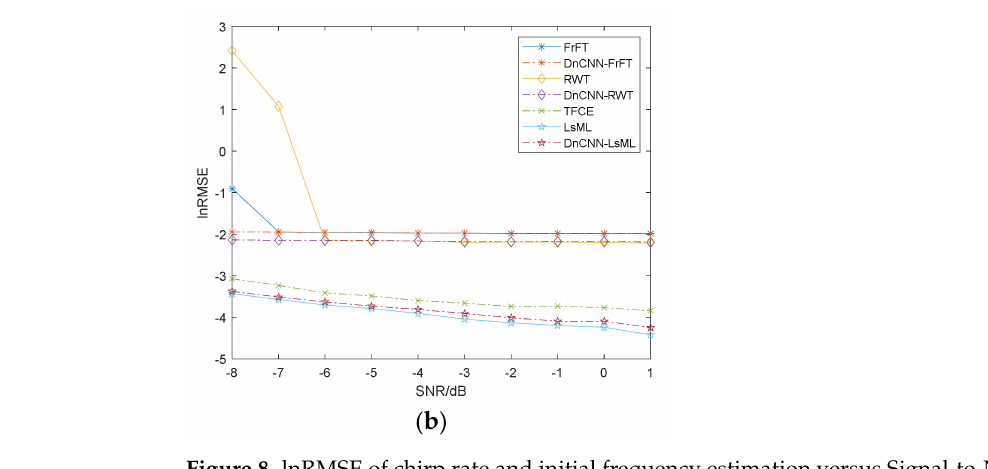
Figure 8. lnRMSE of chirp rate and initial frequency estimation versus Signal-to-Noise (SNR). ( a ) is lnRMSE of chirp rake, ( b ) is lnRMSE of initial frequency. Table 2. Average runtime of 100 signals.